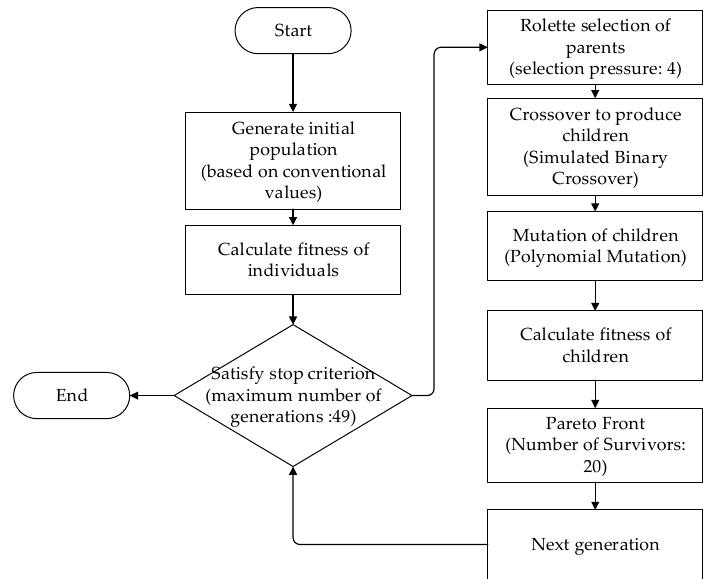
Figure 6. The flow chart of the genetic algorithm (GA) optimization steps.